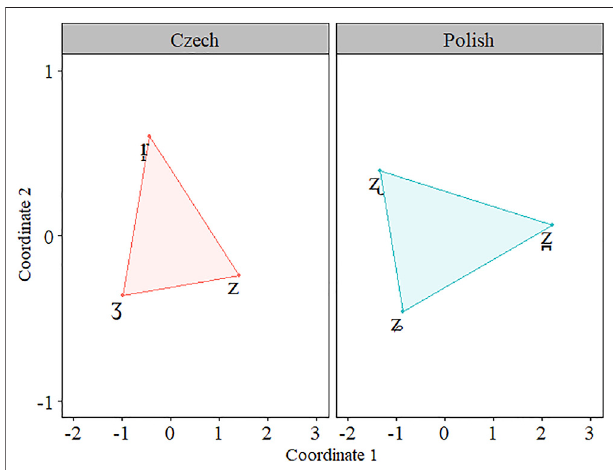
FIGURE 5 | Multidimensional Scaling plot for the perceptual spaces in Czech (red) and Polish (blue).